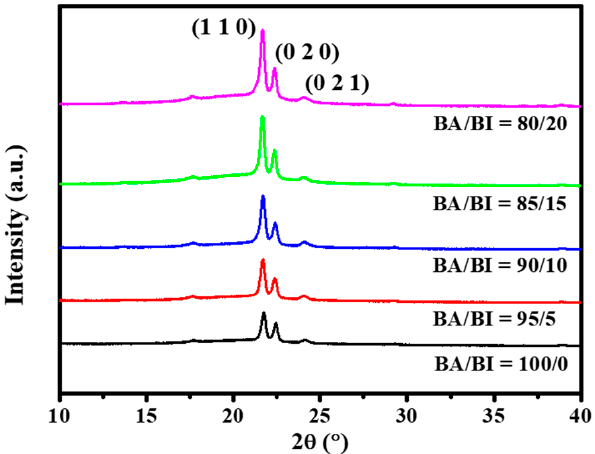
Figure 6. X-ray Di ff raction (XRD) patterns of PBABI copolyesters with di ff erent BA / BI Figure 6. X-ray Diffraction (XRD) patterns of PBABI copolyesters with different BA/BI ratios.